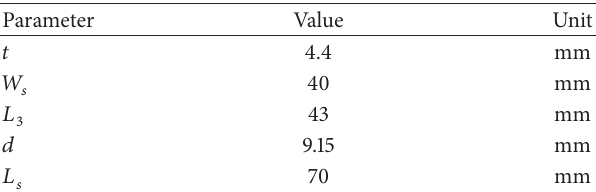
Table 3: The geometrical parameters of the dielectric slabs. Parameter